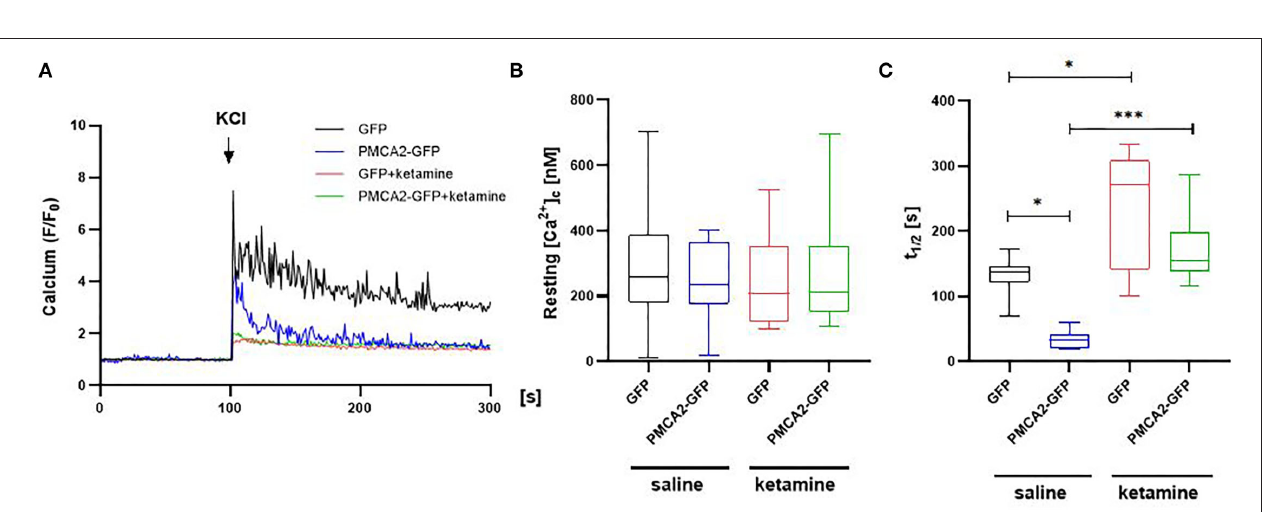
FIGURE 2 | The effect of PMCA2b expression on KCl-induced Ca 2 + transients in the presence or absence of ketamine. (A) Representative traces of Fluo-4 fluorescence intensity (F/F 0 ) changes in response to 30mM KCl pulse measured in single cells using Leica DMi8 inverted microscope. (B) Quantification of a resting Ca 2 + in cytosol ([Ca 2 + ] c ), n = 17. (C) Halftime of Ca 2 + signal decay, n = 17. For (B,C) , the data are plotted from max to min with the line centered at the mean. * P < 0.05, *** P <